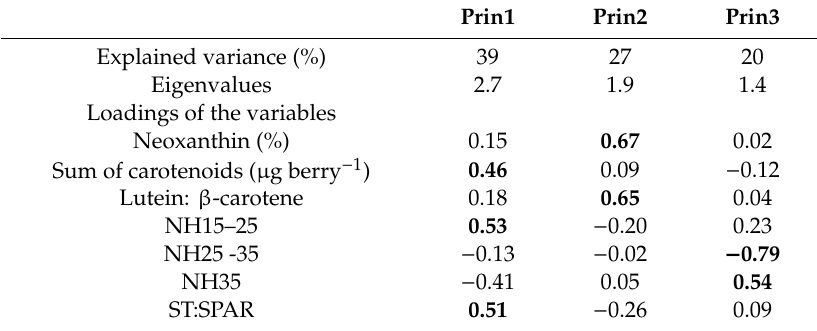
Table 5. Principal Component Analysis (PCA): Percentage of variance explained by the three principal components (Prin1, Prin2, and Prin3), eigenvalues and loadings indicating the correlation between the variables and the three principal components. Prin1 Prin2 Prin3 Explained variance (%) 39 27 20 Eigenvalues 2.7 1.9 1.4 Loadings of the variables Neoxanthin (%)